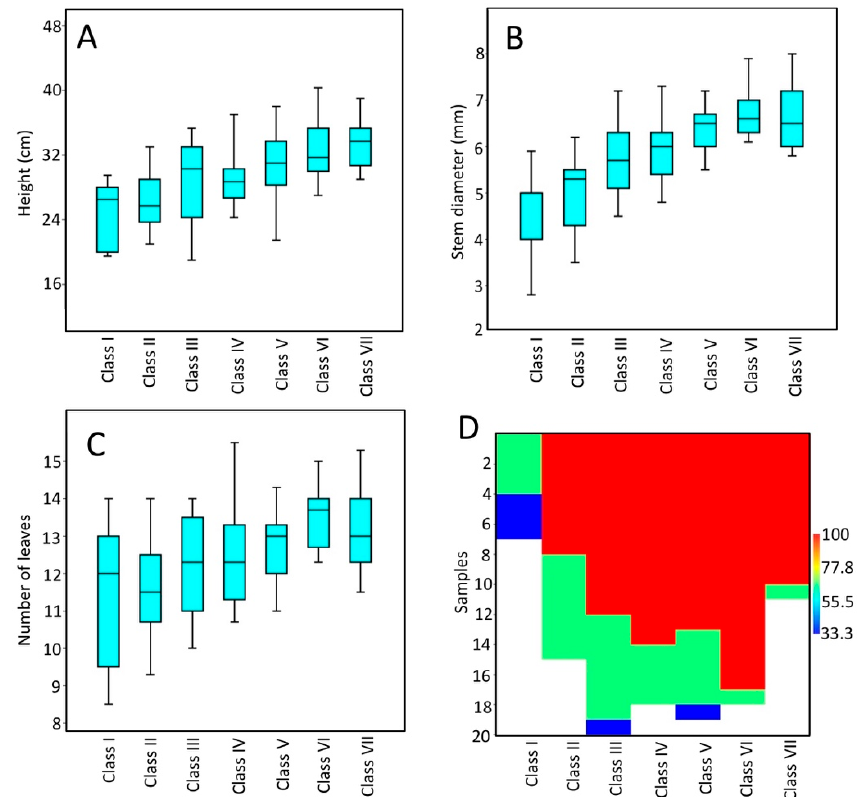
Figure 1. Boxplot diagrams showing the median (bar), 50% confidence intervals (box) and standard deviation (whiskers) for ( A ) plantlet height; ( B ) stem diameter; ( C ) number of leaves for each seed mass class; and ( D ) percentage of plantlet emergence determined as the percentage of germinated seeds across replicates for each seed mass class. Note that the number of replicates is different in each class (see text for details).